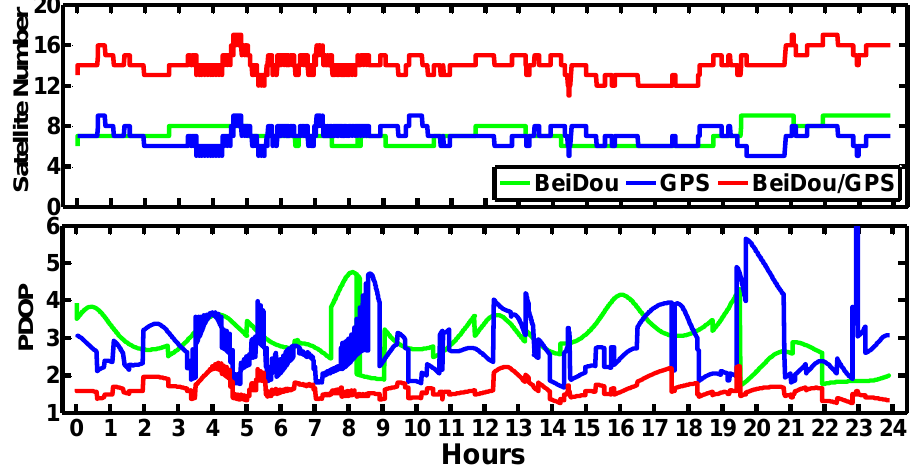
Figure 9. Variations of satellite numbers used and PDOP of the BeiDou, GPS, and BeiDou/GPS of CHDU on September 24,